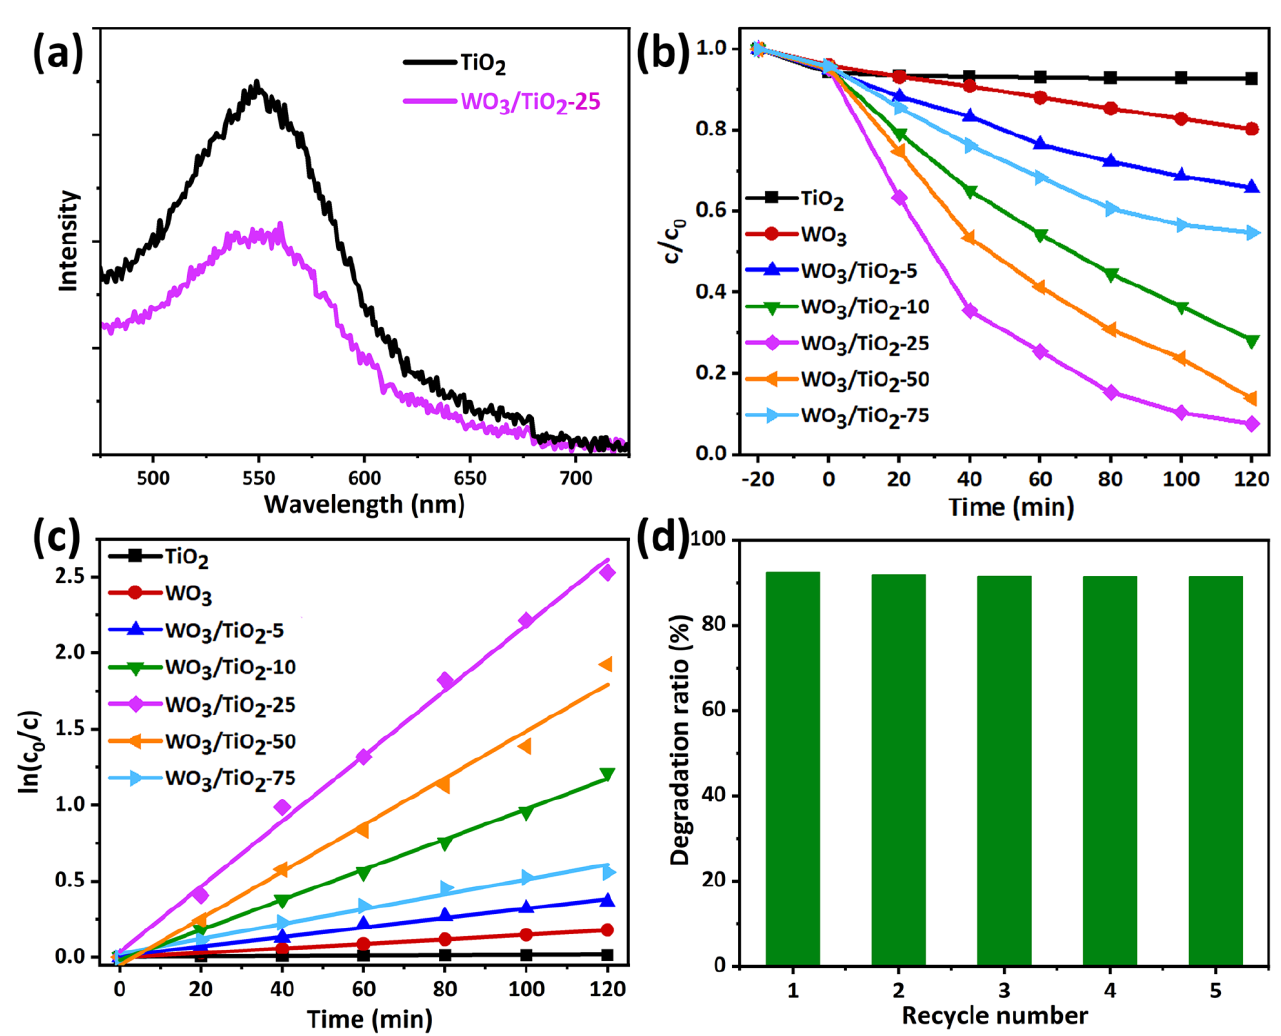
Figure 5. ( a ) Fluorescence spectrum of TiO 2 nanoribbons and WO 3 /TiO 2 − 25 heterojunction. ( b ) Pho- tocatalytic degradation of RhB over various photocatalysts under sunlight irradiation, where C 0 is the initial concentration of the pollutant, and C is the concentration of the pollutant at irradiation time t. ( c ) First-order reaction kinetic curves for the RhB degradation reaction over various photocatalysts. ( d ) Curve of the degradation ratio of RhB versus reuse times of WO 3 /TiO 2 -25.